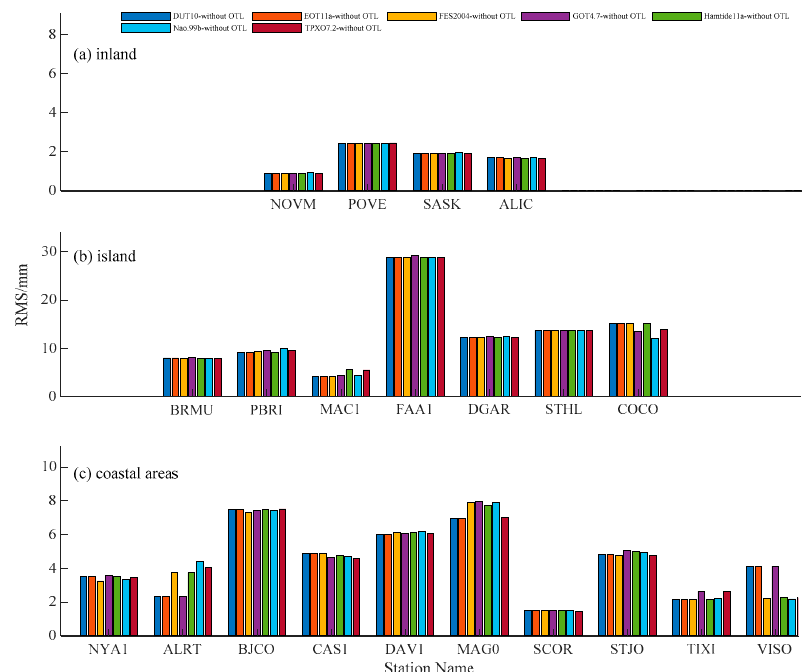
Figure 8. The RMS errors of the differences between the zenith tropospheric delays (ZTDs) calculated with the inclusion or exclusion of the OTL model at ( a ) inland, ( b ) island and ( c ) coastal areas.